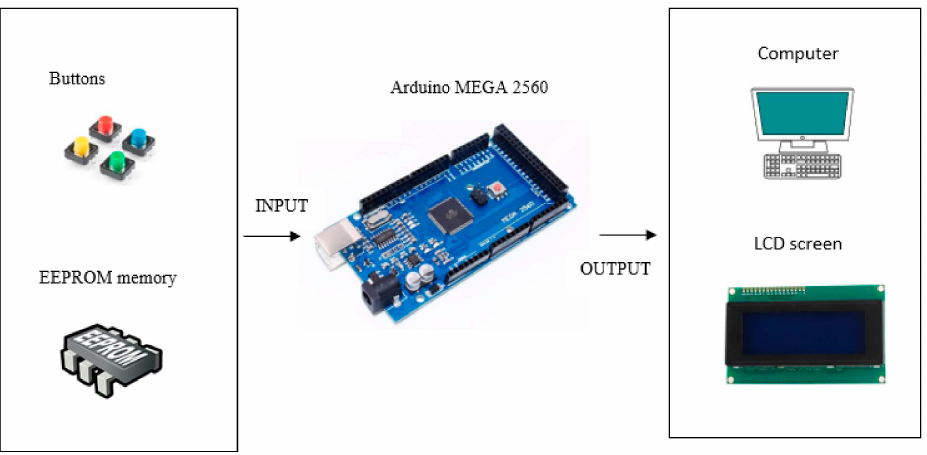
Figure 3. Proposed hardware